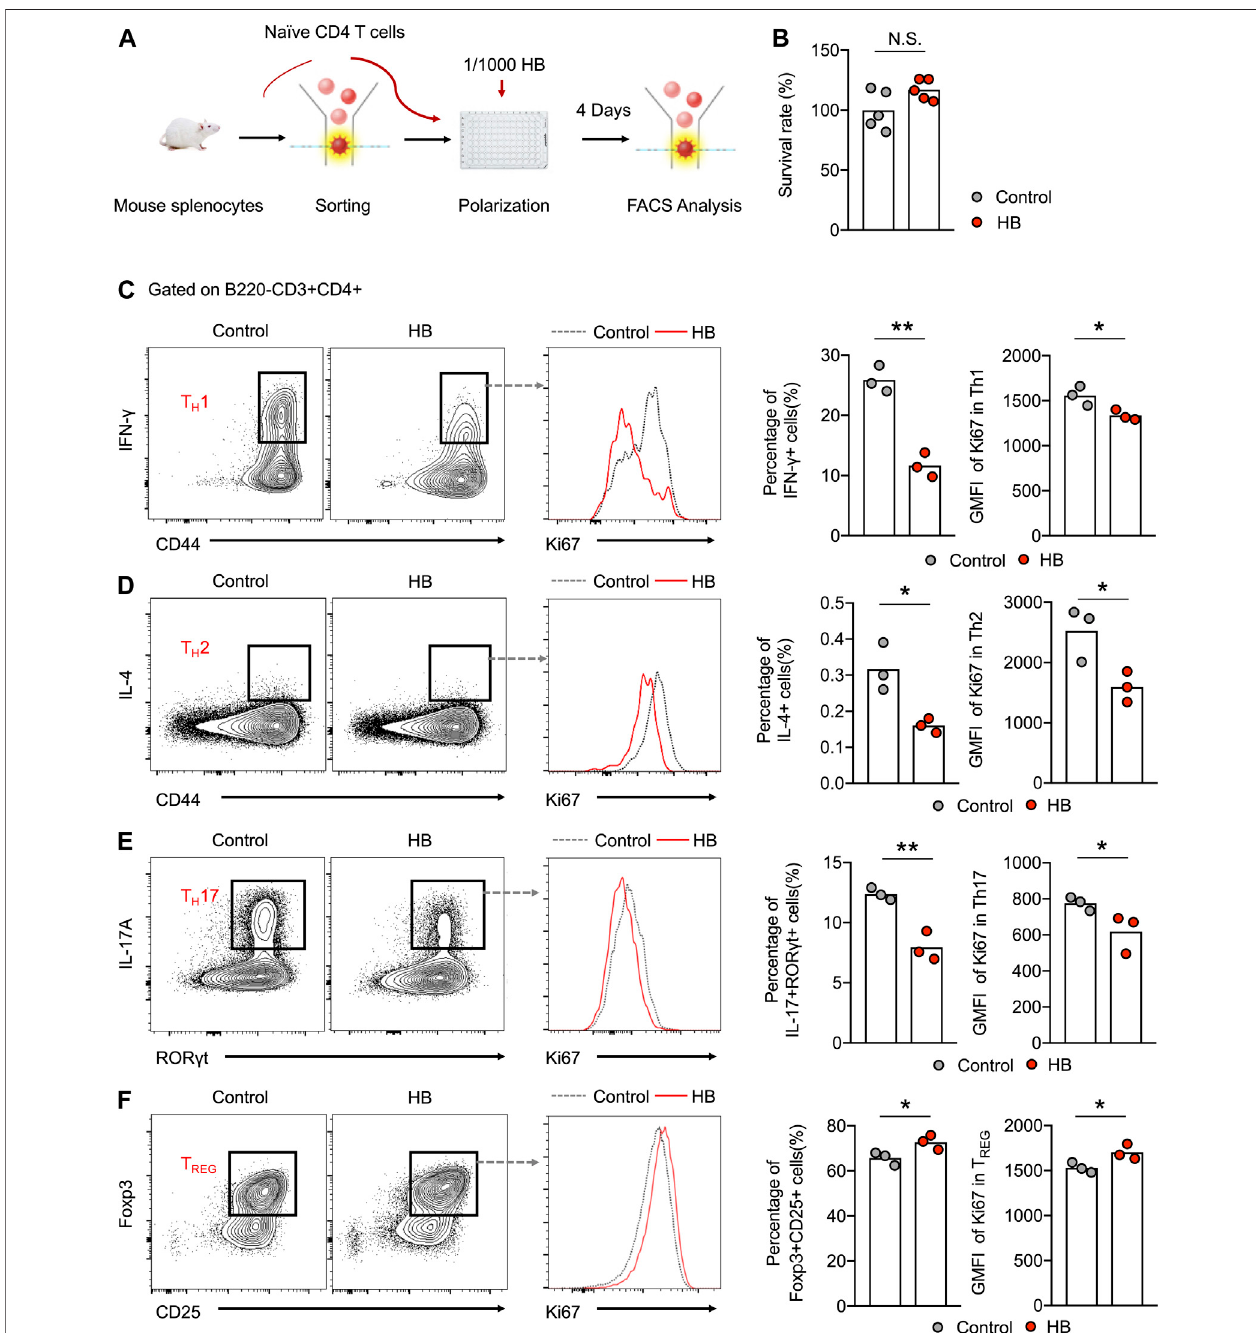
FIGURE 4 | HB directly potentiates regulatory T cell activation and depresses in fl ammatory cells in vitro . (A) Schematic in vitro experiments. Naïve CD4 T cells, derived from mouse splenocytes, were sorted by fl ow cytometry and polarized under different culture conditions with or without 1/1000 HB for 4 days. (B) Survival analysis of HB for naïve CD4 cells was performed using an MTT assay after 48 h of culture with or without 1/1000 H B. (C – F) Representative FACS plots and statistical analysis of in vitro polarized T H 1 (C) , T H 2 (D) , T H 17 (E) , and T REG (F) cells with or without HB treatment. Histogram plots and statistical analysis indicated the changes in Ki67 in different CD4 subsets after HB treatment. Each dot represents one mouse from one of three independent experiments, and bars indicate mean values. Statistical signi fi cance was determined by Student ’ s t -test, * p < 0.05, ** p < 0.01.